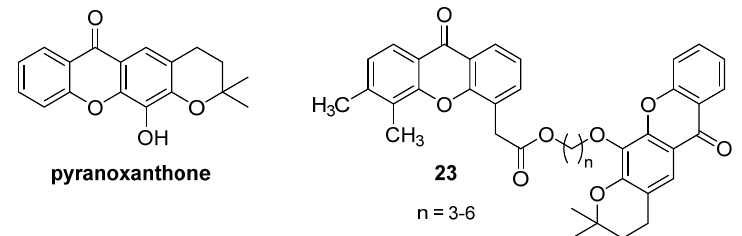
Figure 18. Pyranoxanthone and hybrid derivatives.